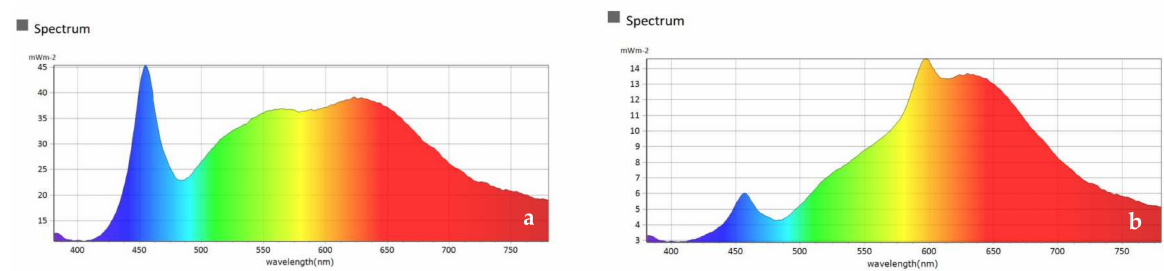
Figure 3. Biodynamic colour temperatures of the Sparckel during a day.